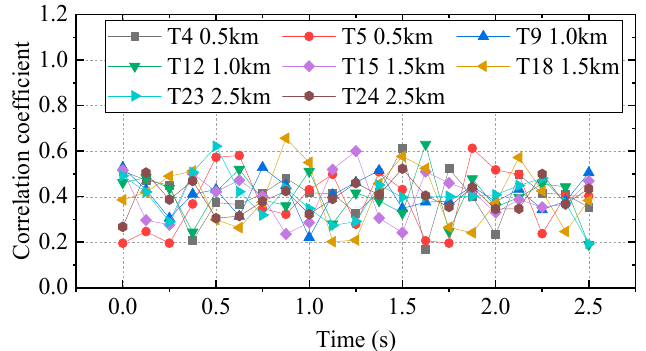
Figure 4. The variation of correlation coefficient with phase difference. Table 2. The correlation coefficient of different measurement points in different phase differences. Measurement Point